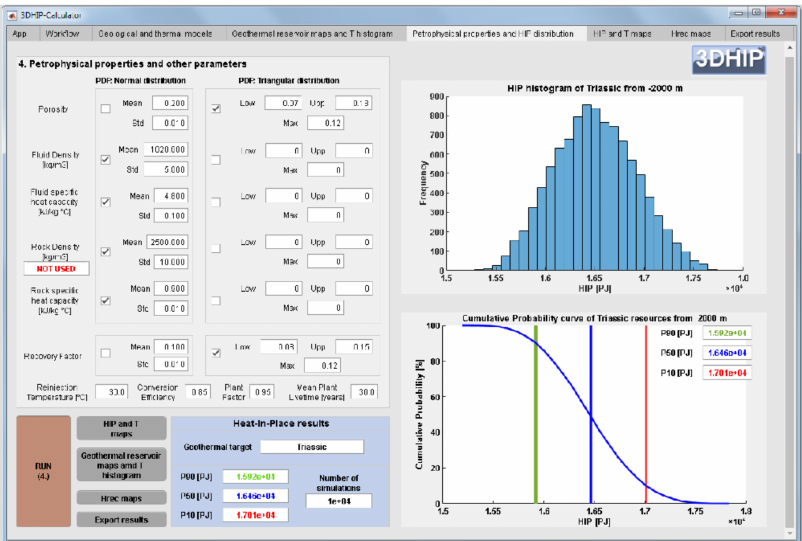
Figure 10. Summary of the petrophysical and operational parameters and PDFs used in example 3. For this example, the 3D geological model includes a rock density value for each voxel, and for this reason, it was not stochastically simulated using a pre-scribed PDF. On the right: the HIP histogram and the HIP CDF’s results for the entire target reservoir (P10, P50, and P90).